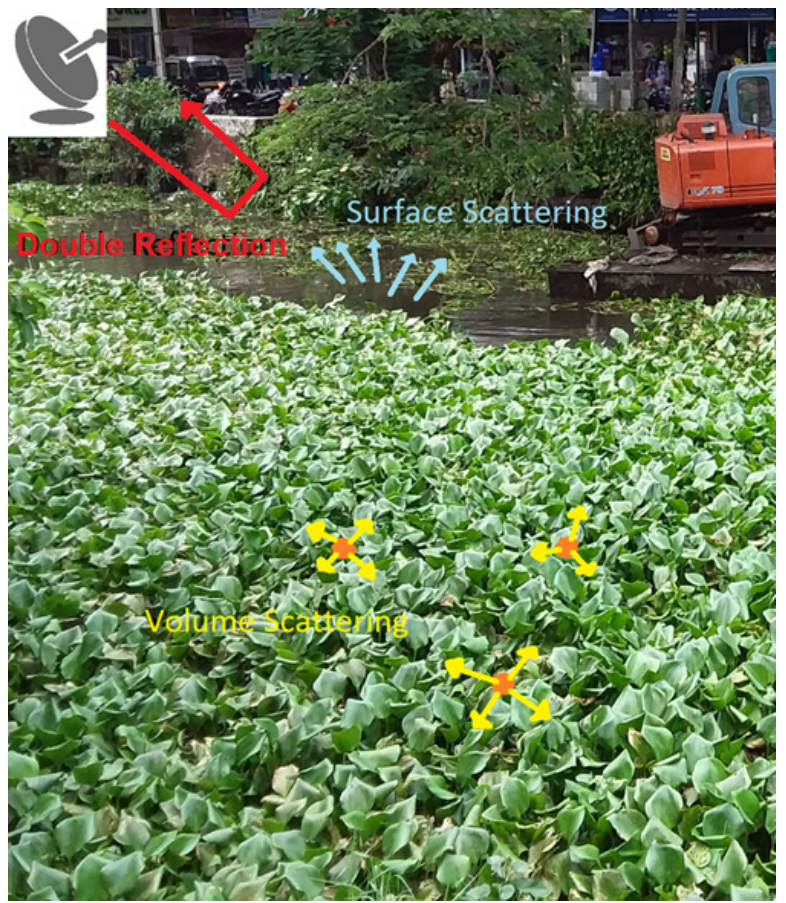
Figure 1. Scattering mechanisms present from radar satellite within a water hyacinth infested canal.